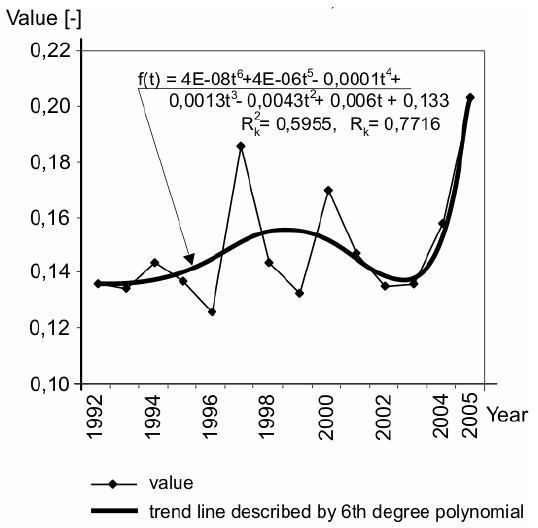
Fig 4. Index of rate of fatal accidents per 1000 persons